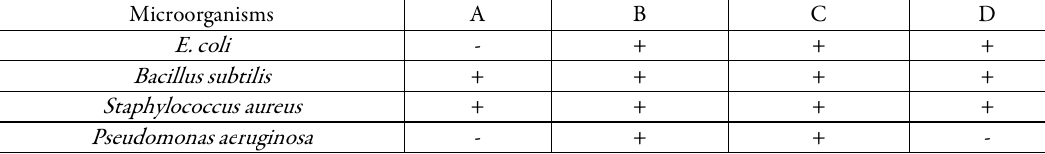
Table 3. Distribution of bacteria contaminant in the bread samples Microorganisms A B C D E. coli - + + + Bacillus subtilis + + + + Staphylococcus aureus + + + + Pseudomonas aeruginosa - + + -